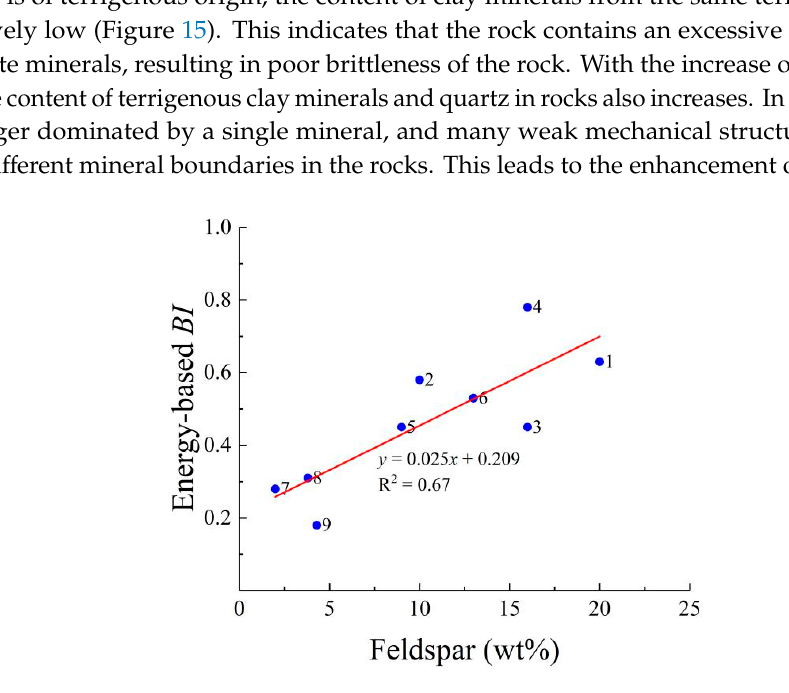
Figure 15. The relationship between the content of clay minerals and feldspar content. Figure 16. The relationship between energy-based BI and the content of clay minerals.